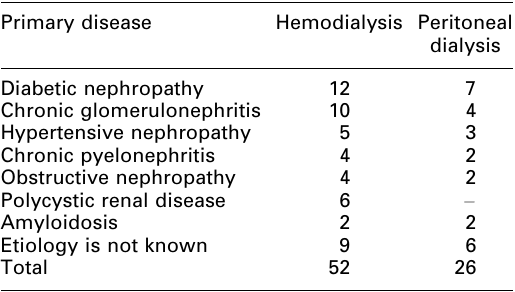
Table 1. The primary diseases of the patients Primary disease Hemodialysis Peritoneal